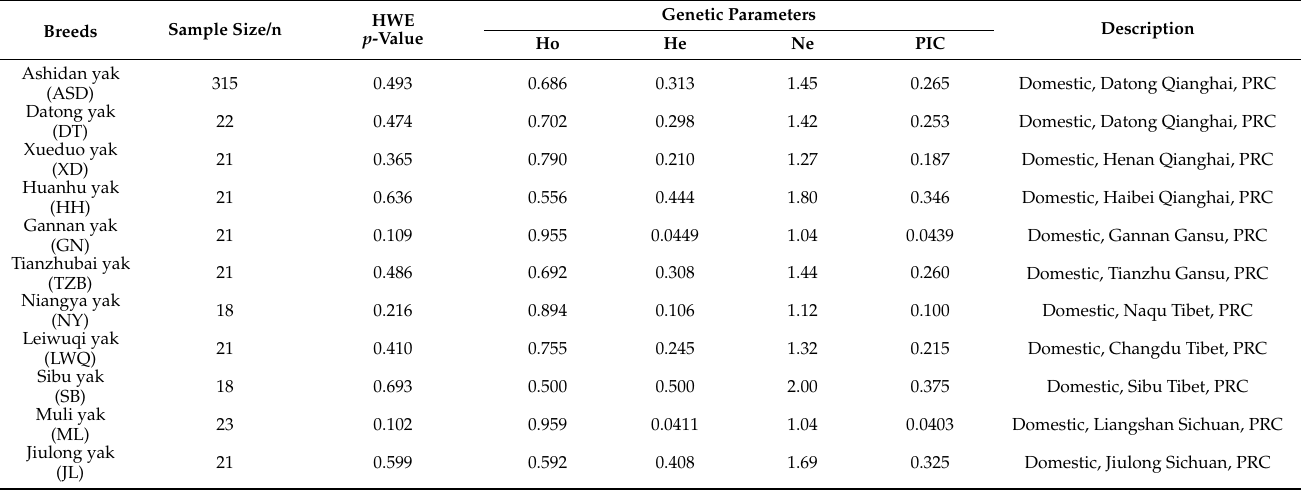
Table 3. The genetic parameters of Yak